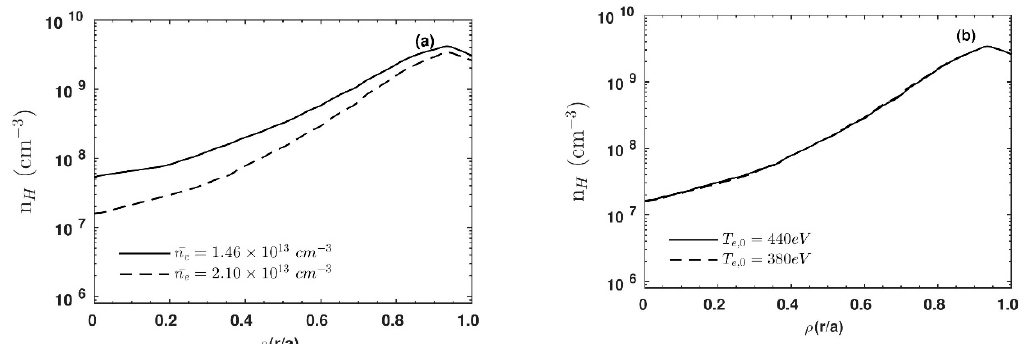
Figure 5. ( a ) Simulated neutral H density (solid curve) for shot #28917 having n e = 1.46 × 10 13 cm − 3 Figure 5 . (a) Simulated neutral H density (solid curve) for shot #28917 having n e =1.46 × 10 13 cm -3 and and (dashed curve) for shot #28753 having n e = 2.10 × 10 13 cm − 3 . ( b ) Simulated neutral H density for (dashed curve) for shot #28753 having n e = 2.10 × 10 13 cm -3 . (b) Simulated neutral H density for plasma plasma having electron density 2.10 × 10 13 cm − 3 when the core electron temperatures are taken to be having electron density 2.10 × 10 13 cm -3 when the core electron temperatures are taken to be 440 (solid 440 (solid curve) and 380 eV (dashed curve) for shot #28917 and shot #28753, curve) and 380 eV (dashed curve) for shot #28917 and shot #28753, respectively.